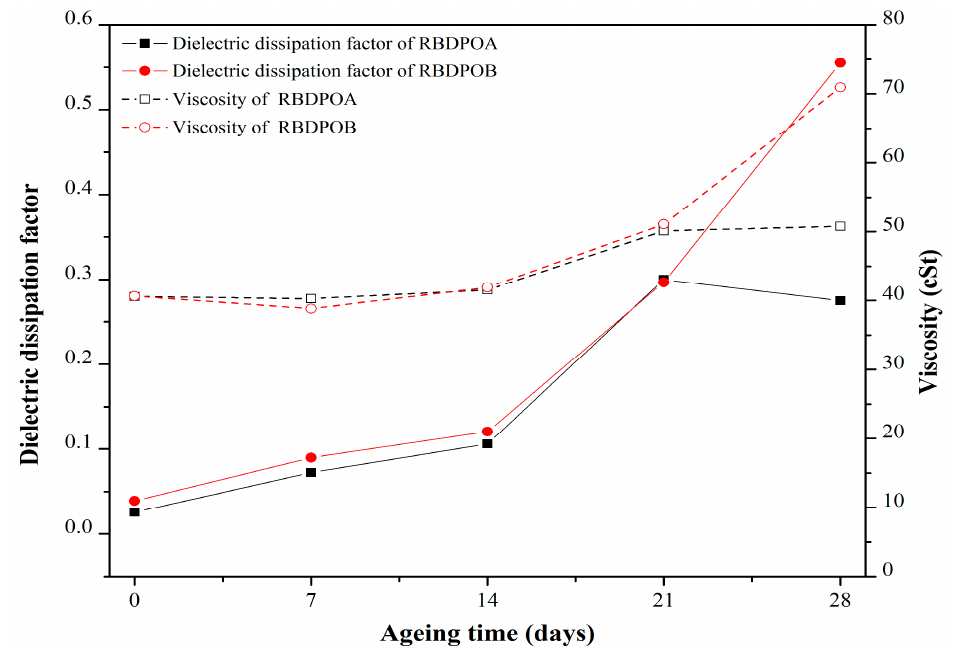
Figure 10. Relationship between dielectric dissipation factor and viscosity of RBDPO aged at 170 °C under open conditions.